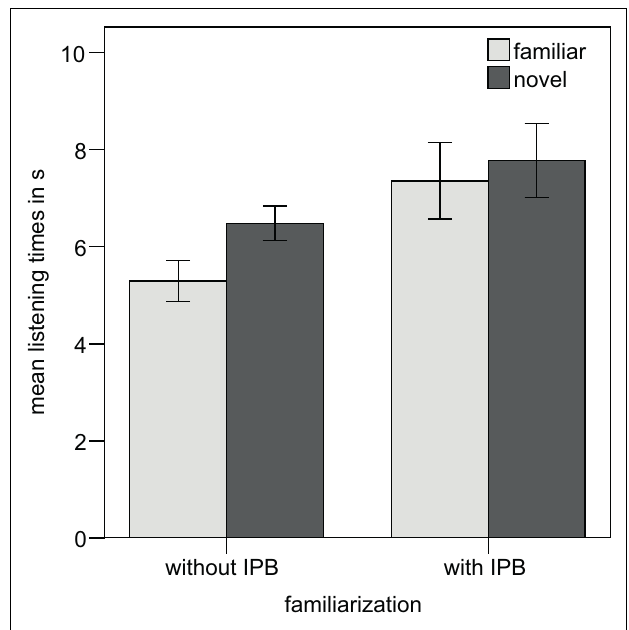
FIGURE 3 | Mean listening times for Experiment 1, separated by familiarization